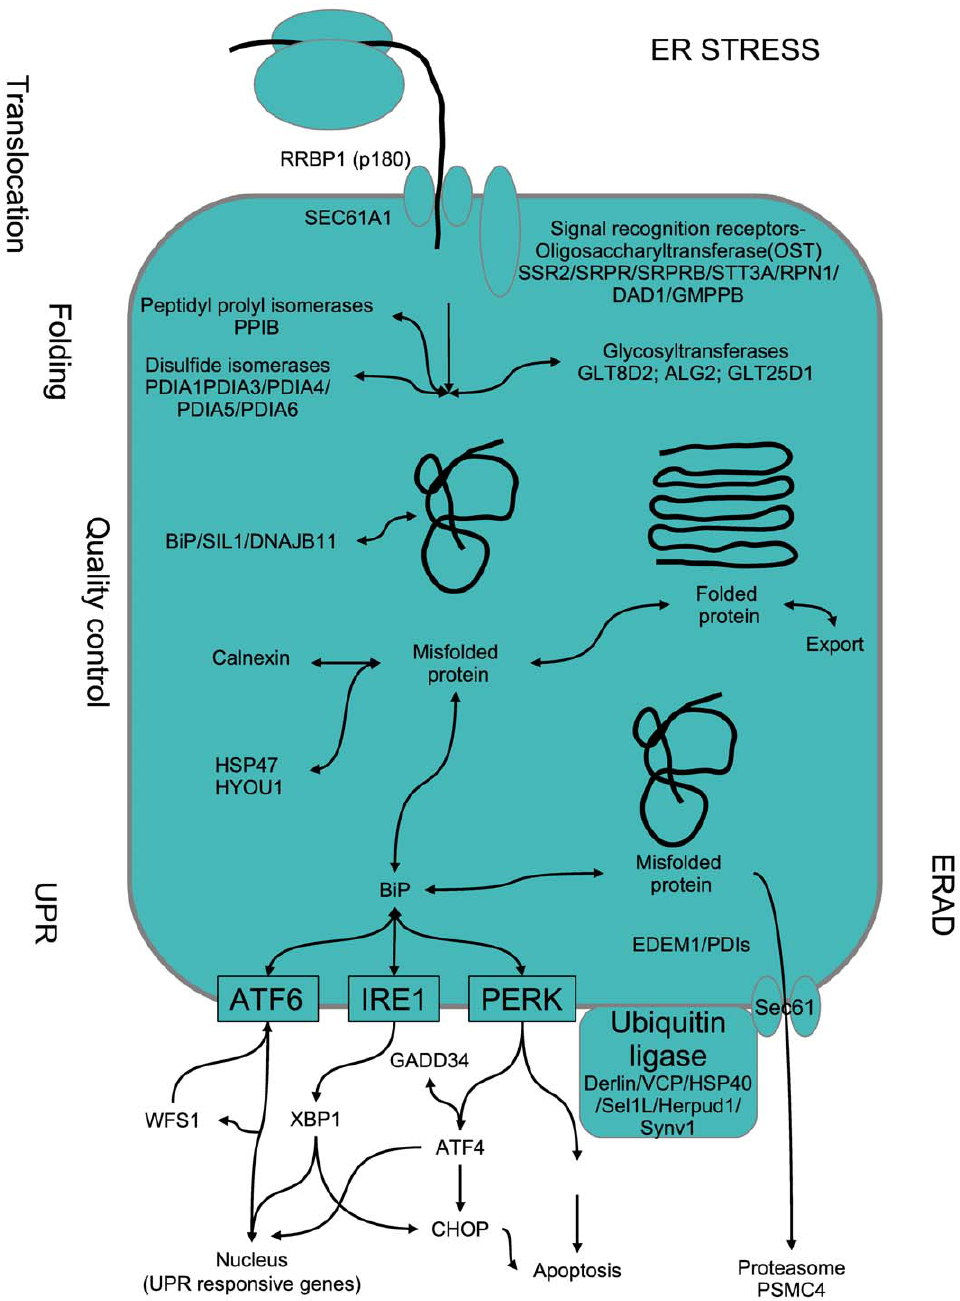
Figure 5. Schematic cartoon of the main pathways involved in the endoplasmic reticulum (ER) stress response. Proteins are translocated directly from the ribosome into the ER and protein folding takes place with the help of specific chaperones. If folding is correct, the proteins follow their path to the Golgi complex and the secretory pathway. If misfolded proteins accumulate in the ER lumen, the UPR can be triggered and signals will be sent to the nucleus and apoptosis could be induced through CHOP. All the proteins represented in the cartoon are significantly upregulated by doxycycline treatment.